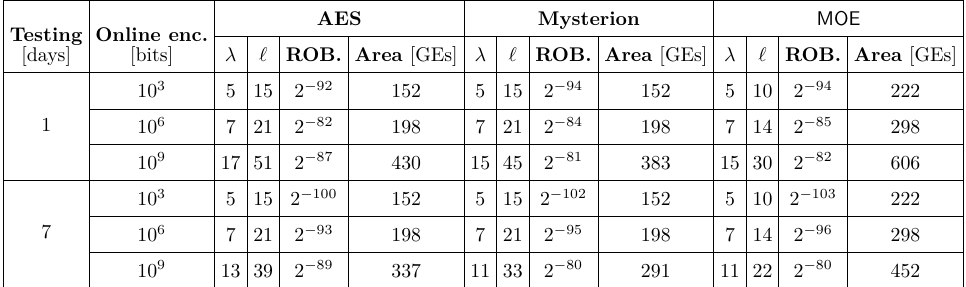
Table 6: Robustness guaranttes for different testing periods and trusted area requirements for Trojan-Resilient implementations of the AES, Mysterion and MOE . Testing Online